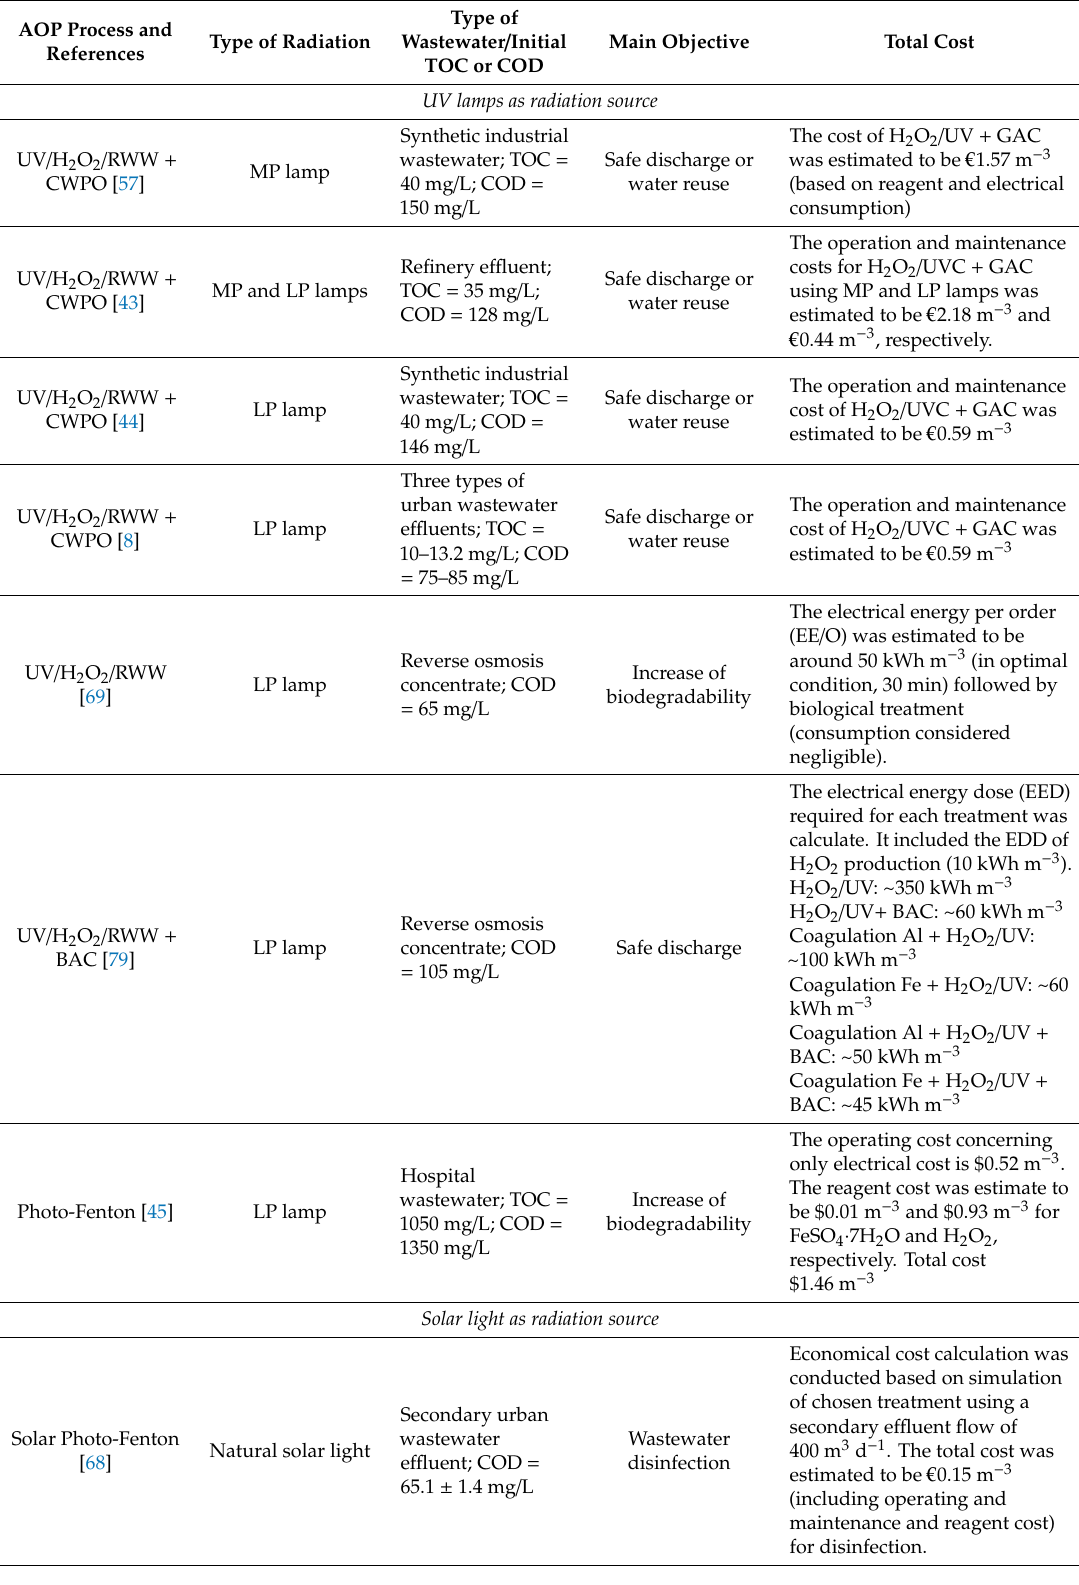
Table 2. Operation and maintenance cost for photo-Fenton process and UV / H 2 O 2 /